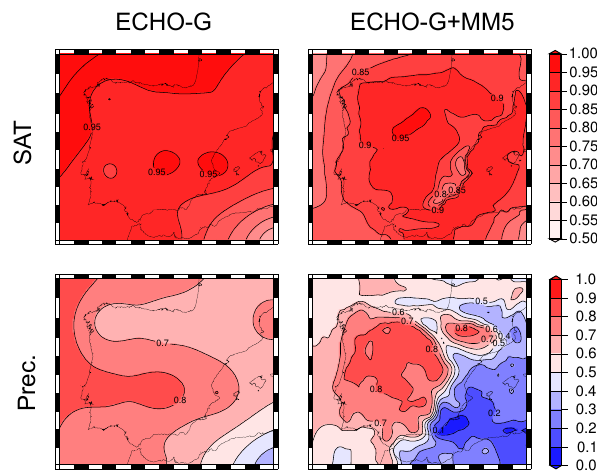
Fig. 13. Precipitation anomalies for winter (up row) and summer (bottom row) in the 1671-1700 period respect to 1900-1990. The figure shows the results for ECHO-G (left), ECHO-G+MM5 (cen- tre) and the precipitation reconstruction (right). ure 11. Nevertheless, the added value of the RCM appears in the high-frequency domain. Top (bottom) row in Figure 14 shows the correlation between the annual series of SAT (precipitation) in every each grid point and the corresponding mean value for the IP domain in ECHO-G (left) and MM5 (right). The series have been previously filtered through a high-pass filter which only allows frequencies higher than 0.3 yr − 1 . This filtering prevents the slow variations in the climate to increase the correlation among grid points in dif- ferent locations of the domain. In SAT, ECHO-G is hardly able to make any differences between several areas within the IP. On the contrary, MM5 reduces the correlation be- tween the mean behaviour of the IP and some areas in the Southeast, reaching values below 0.8. The corresponding maps in the low-frequency domain (not shown) are identi-